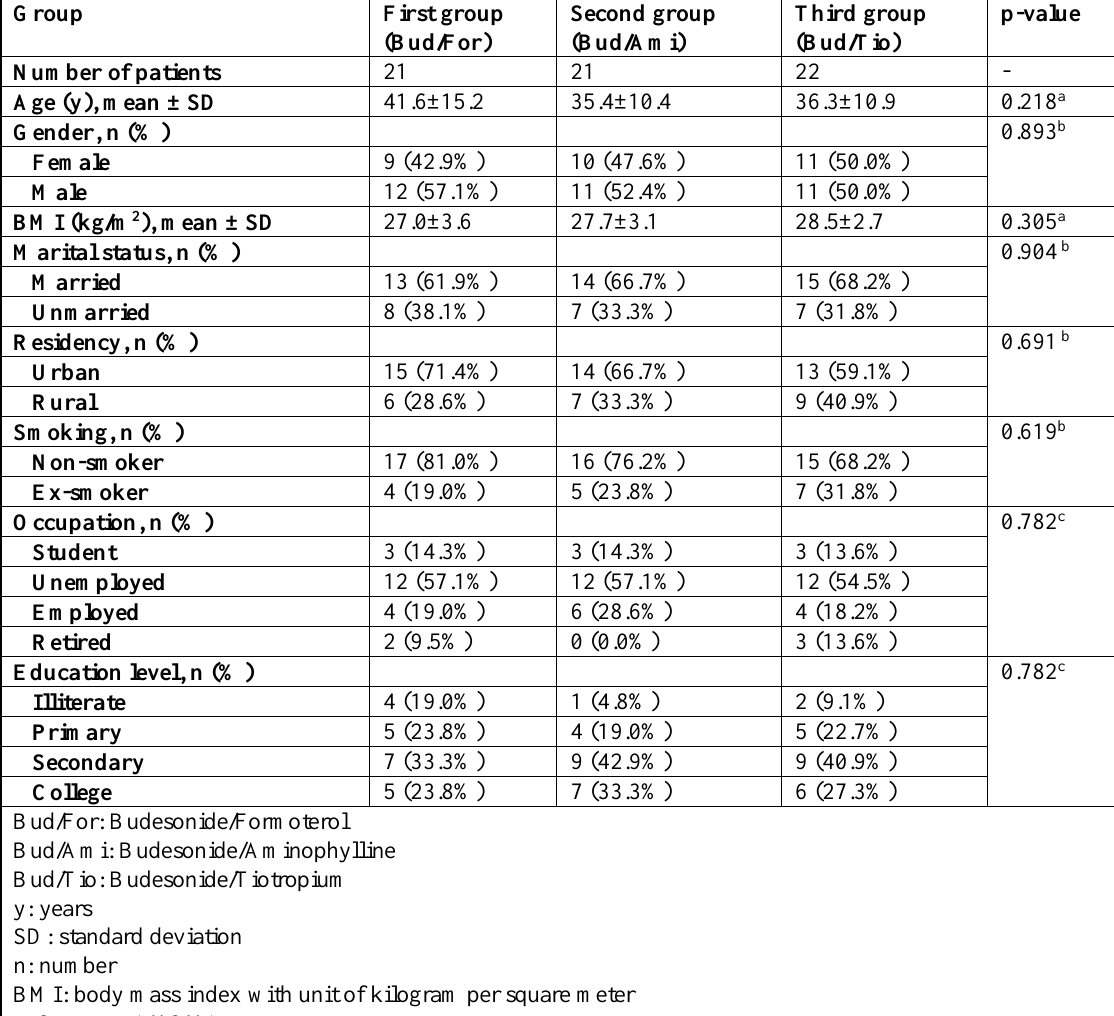
Table 1. Comparison of Socio-demographic data between the study groups.